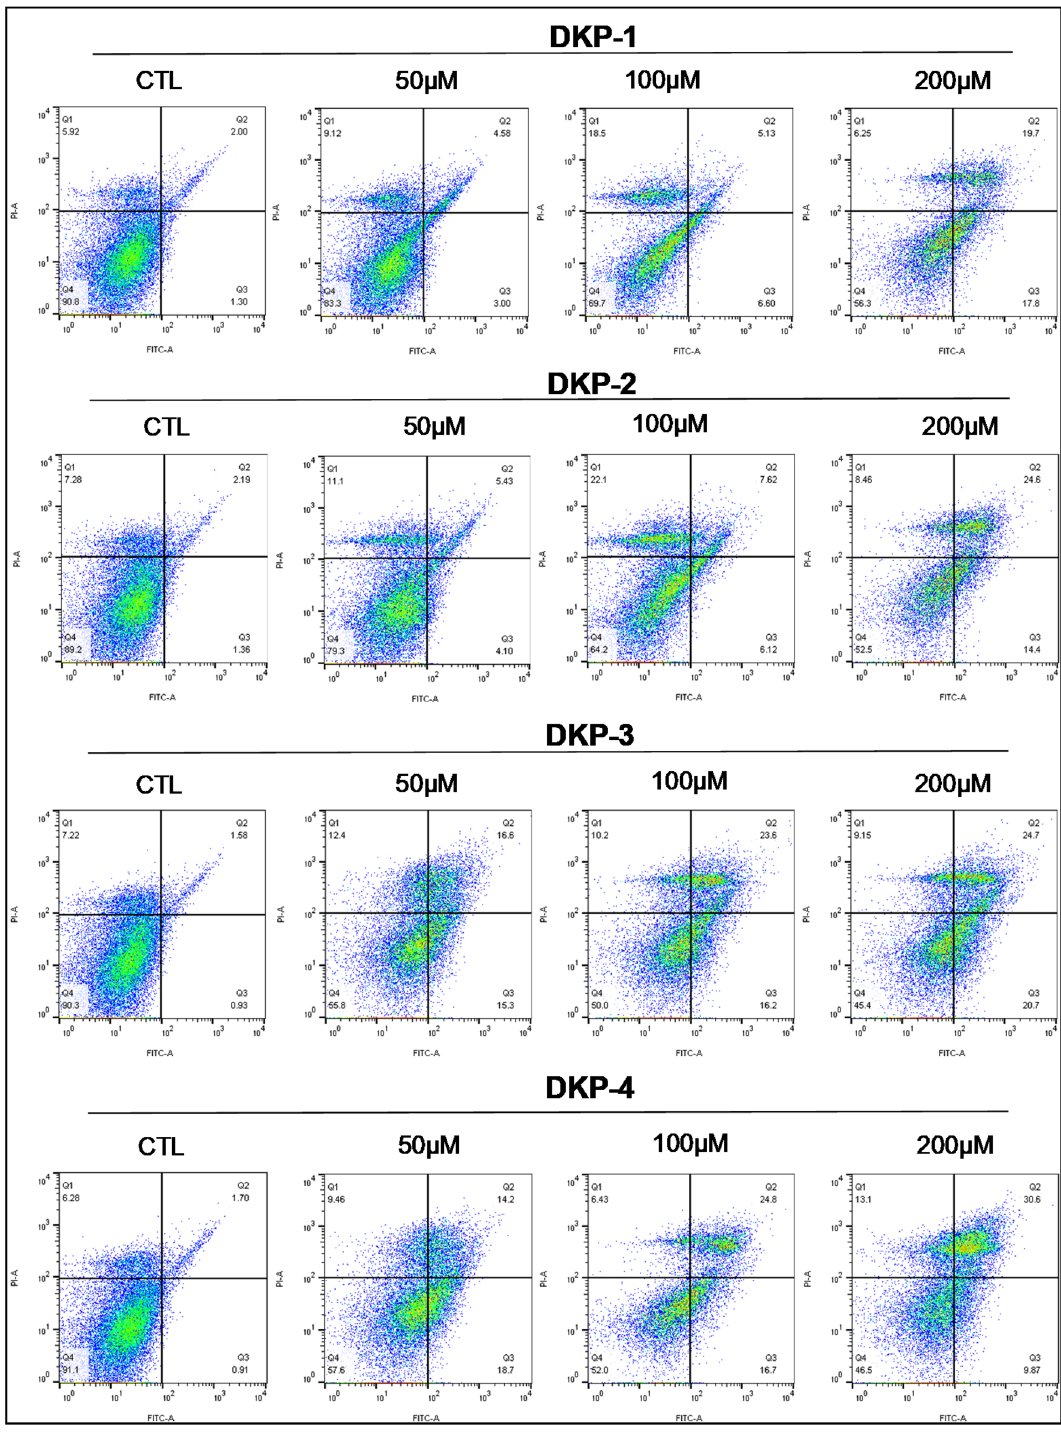
Figure 3. Cyclic dipeptide induces apoptosis in HT-29 cells. Annexin V-FITC/PI double staining was performed to analyze apoptotic cell populations by flow cytometry. HT-29 cells were treated with different doses (50, 100 and 200 μM) of four DKPs as indicated for 24 h. Percentage of the dead (Q1), late apoptotic/necrotic (Q2), early apoptotic (Q3) and viable (Q4) cells were shown in quadrant plot. CTL